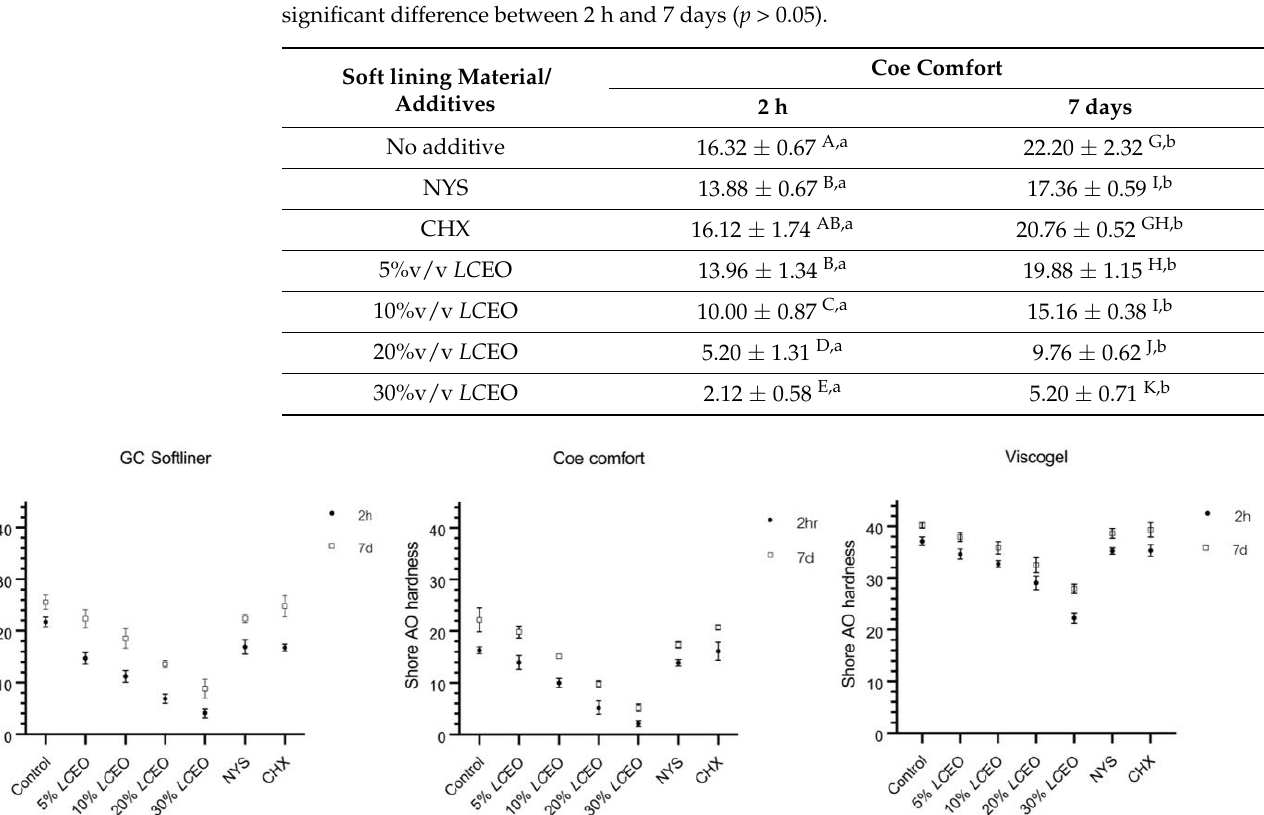
Figure 4. Shore AO hardness values (mean ± SD) of GC soft liner, Coe comfort and Viscogel with and without additives are presented for both 2 h and 7 day incubation times. All three soft lining materials performed evenly, with more incubation time resulting in an increase in Shore AO hard- ness ( p < 0.05). When adding higher concentration of LC EO, the surface hardness decreased ( p <